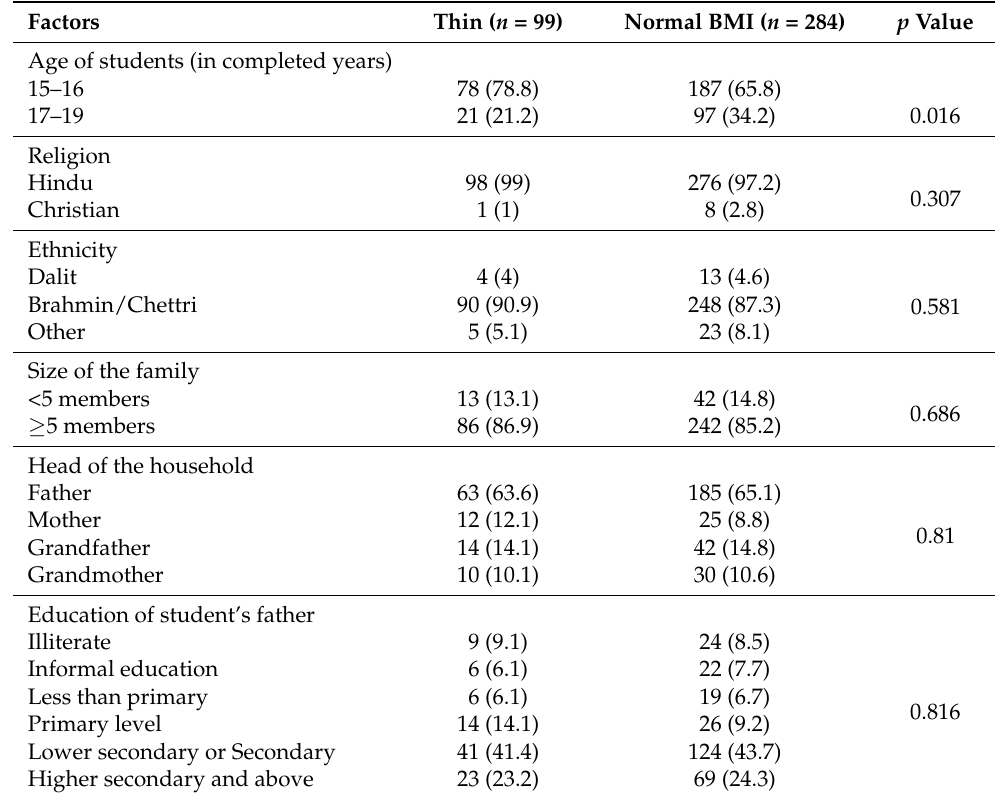
Table 2. Socio-demographic factors of thin and normal BMI